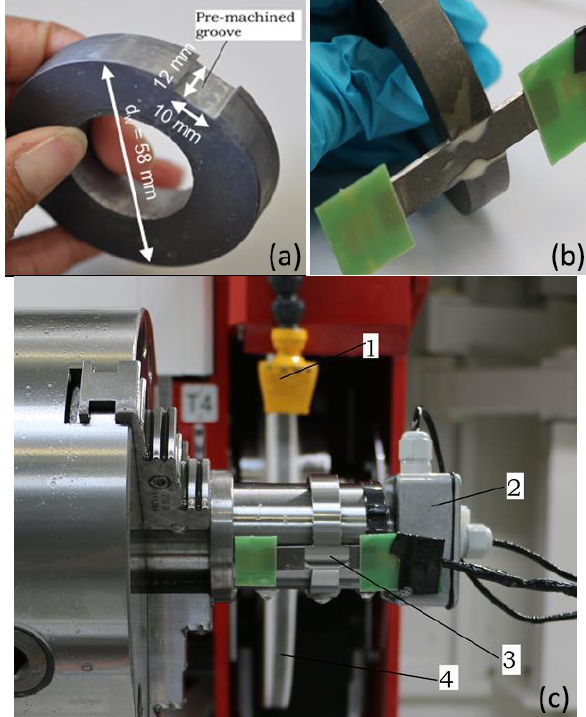
Figure 10. (a) Workpiece with the pre-machined groove to em- bed the sensor inlay; (b) sensor inlay embedded on the groove up- side down; (c) experimental setup: (1) nozzle for coolant, (2) box for holding and protecting the electronic components, (3) sensor- integrated workpiece, and (4) grinding